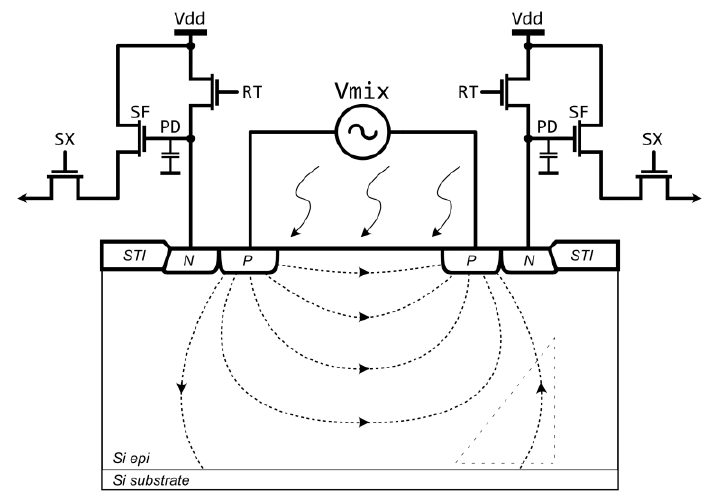
Figure 10. 3-transistor (3T) 2 tap iTOF CMOS pixel architecture.